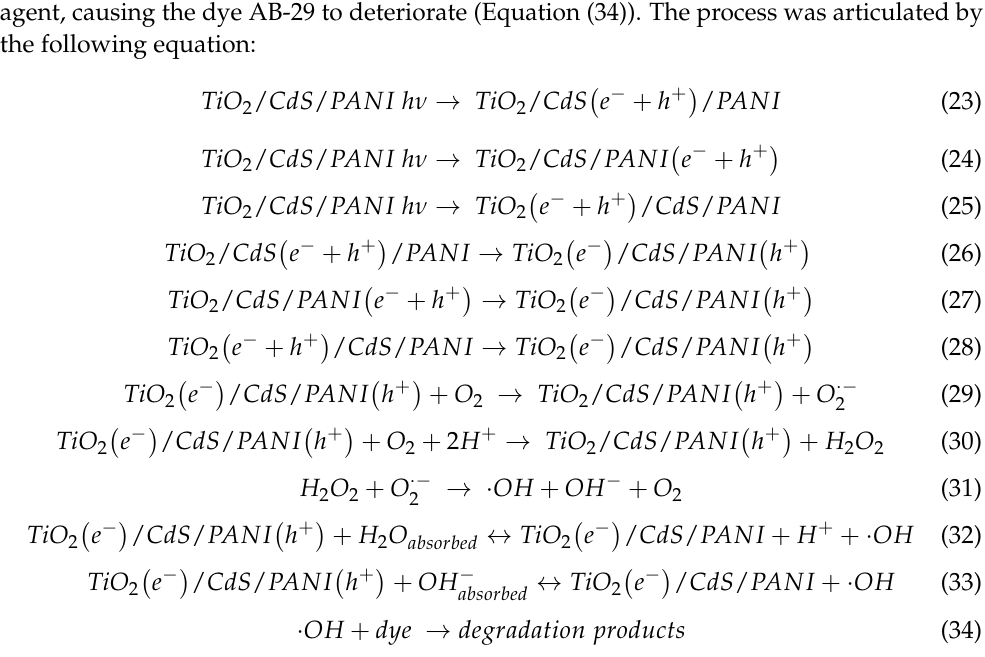
Comparative Analysis: Table 1 represents the earlier reported work on the degradation of AB-29 dyes. Table 1. Represents the comparison results of degradation of AB-29